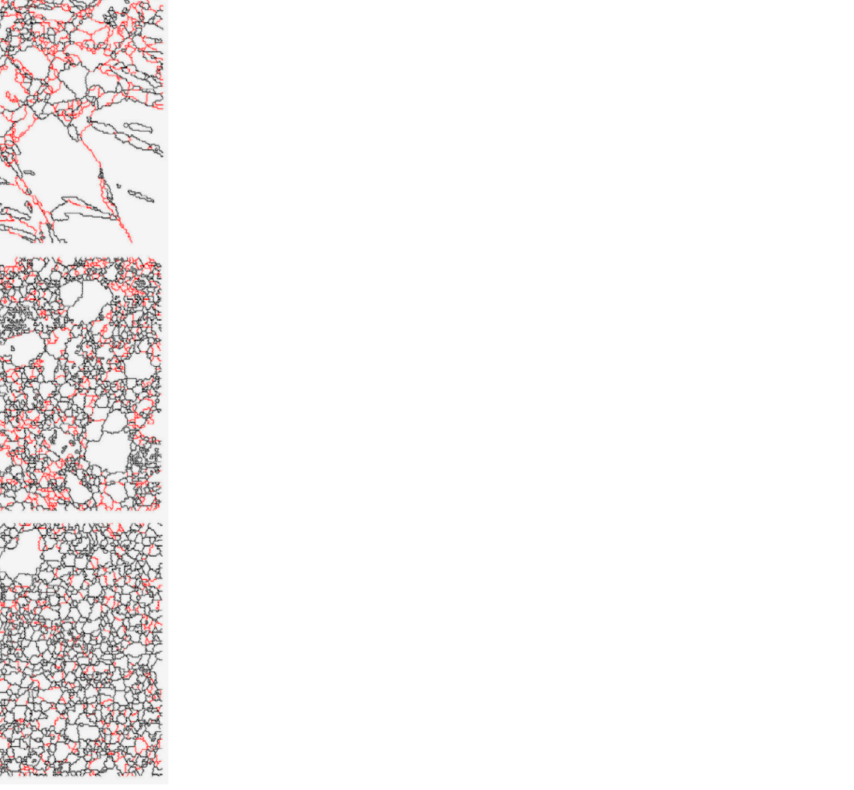
Figure 4. Evolution of the grain structure of pure magnesium during HPT processing [28].